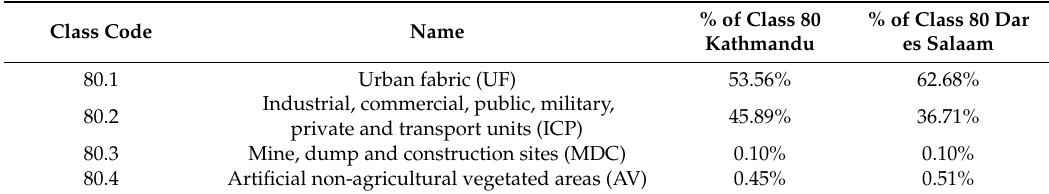
Table 9. Distribution of urban LULC classes in the enhanced GL30 for Kathmandu and Dar es Salaam study areas.